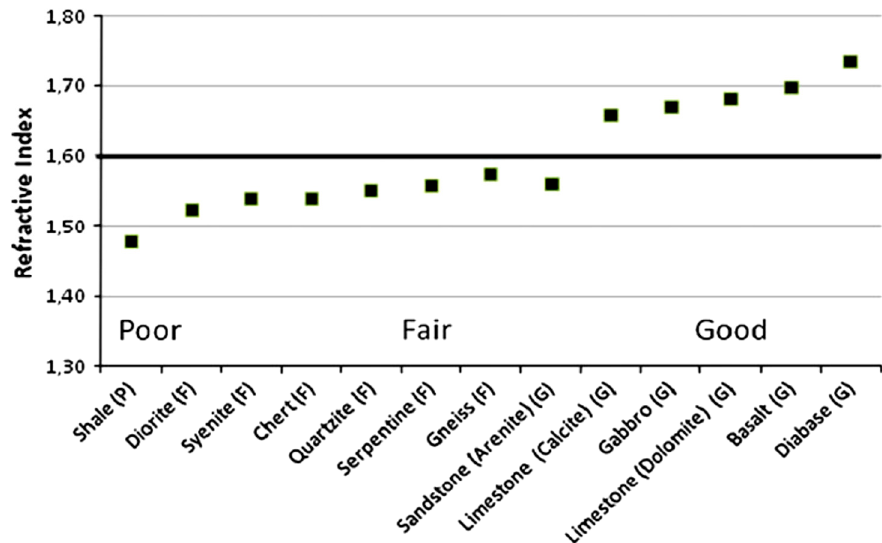
Figure 3. High refractive index value for aggregates and minerals classified according to their degree of resistance to stripping (P—poor, F—fair, and G—good) [65,80].